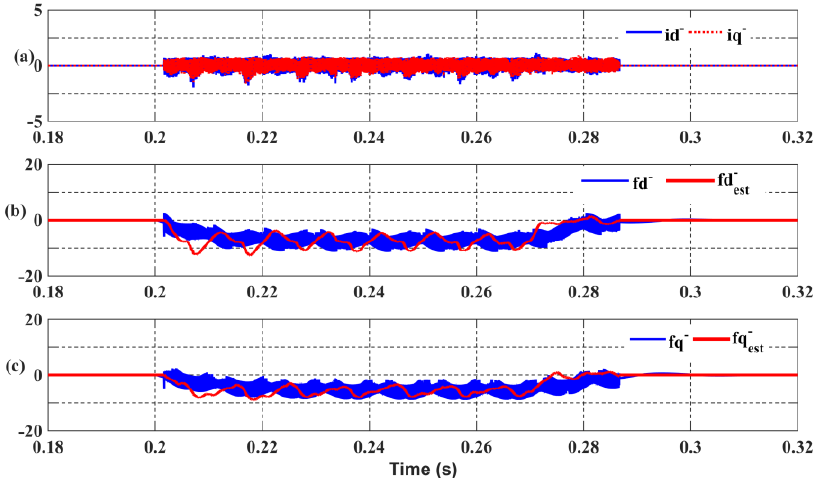
Figure 10. Simulation B results with dual positive- and negative-sequence controllers: ( a ) negative sequence dq axis currents (A), ( b ) f gd− and f̂ gd− (V), and ( c ) f gq− and f̂ gq− (V).